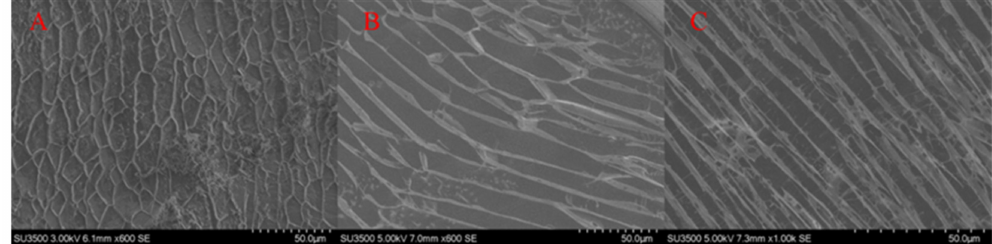
Figure 7. The structures of the gel samples JM86 ( A ), #1 ( B ), and #2 ( C